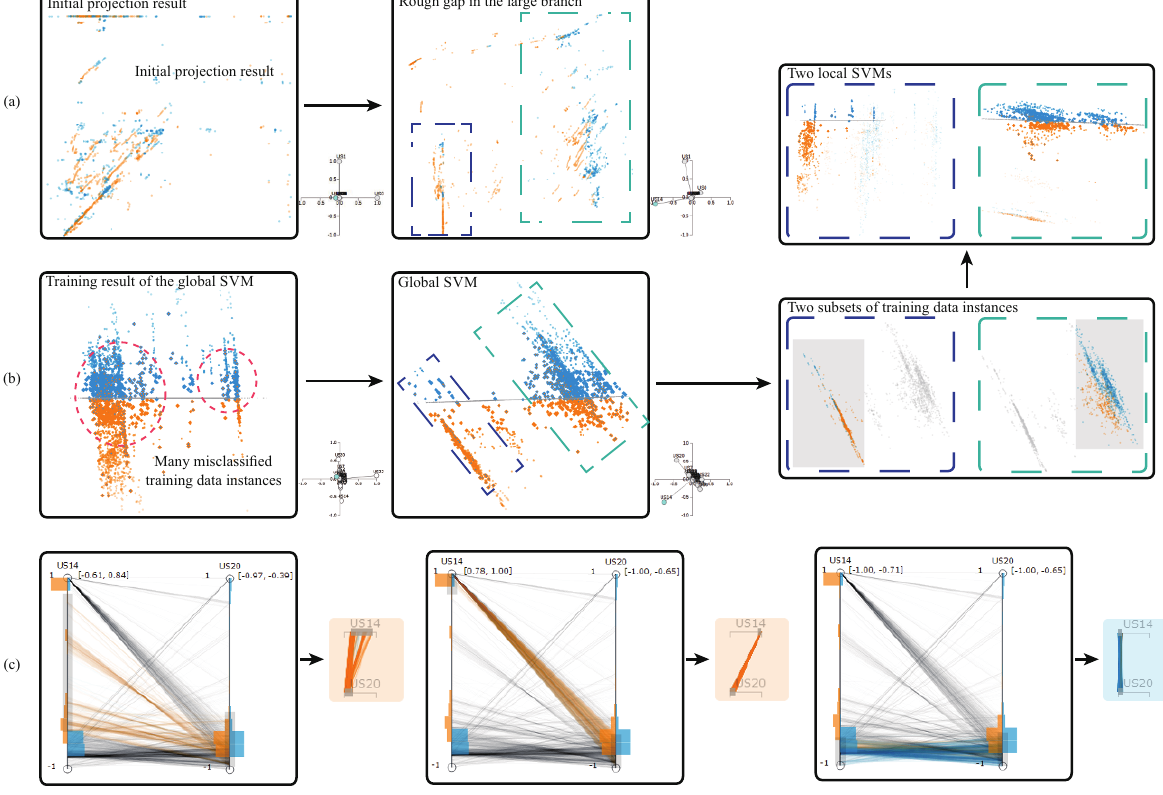
Fig. 9 Analyzing the Wall-following Robot Navigation dataset. (a) After adding the weight of projection for dimension US14, the dataset is approximately separated into two branches in the blue and green boxes. A coarse gap appears in the large branch on the right side. (b) The result of a global SVM model is not acceptable because too many data instances are misclassified (marked in the two red circles). When increasing the projection weight on dimension US14, the projection result shows that the separating hyper-plane of the global SVM model is located in a different direction to the gap found in the previous step. Two separate local models are created based on the two branches. (c) Three classification rules are extracted based on the result of the local model built on the large